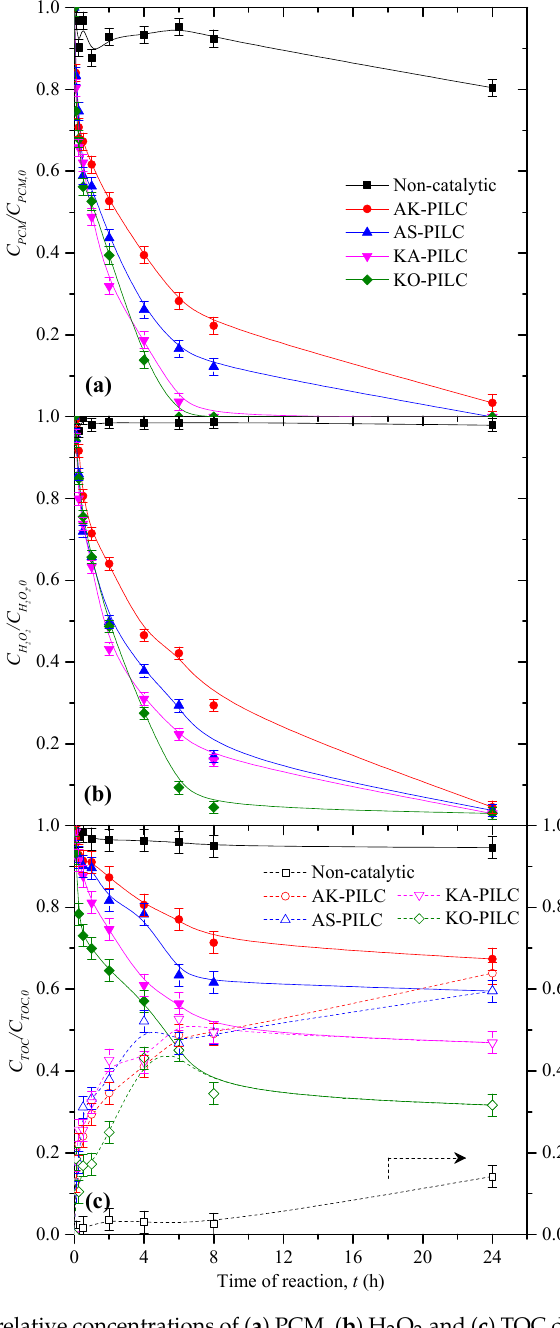
Figure 5. Profile of relative concentrations of ( a ) PCM, ( b ) H 2 O 2 and ( c ) TOC during the CWPO of PCM with pillared clays. Operating conditions: C PCM = 100 mg L − 1 , C H initial pH = 3.5 and T = 80 °C.